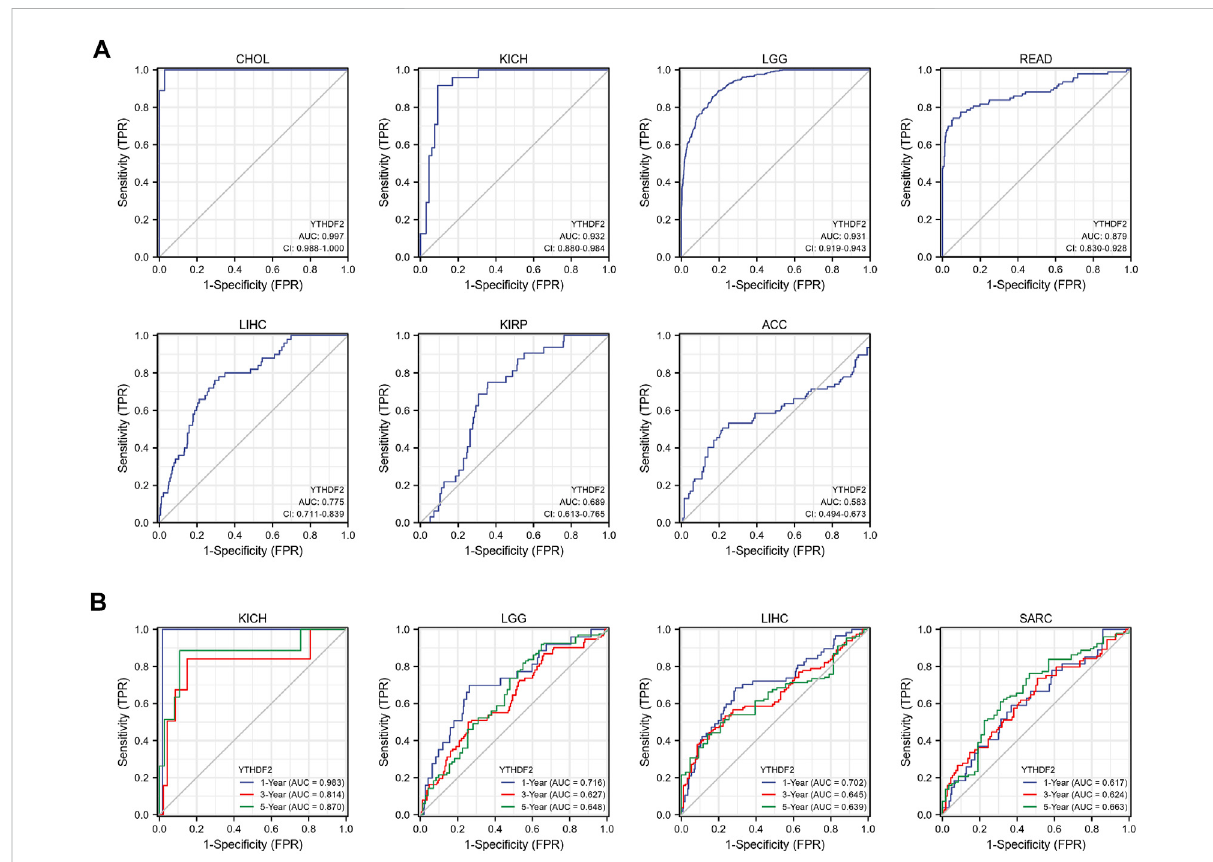
FIGURE 4 The predictive potential of YTHDF2 on prognosis. (A) ROC analysis demonstrates the predictive potential of YTHDF2 on prognosis in CHOL, KICH, LGG, READ, LIHC, KIRP, and ACC. (B) Time-dependent ROC analysis demonstrates the predictive potential of YTHDF2 on 1-year, 3-year, and 5-year survival rate of patients with KICH, LGG, LIH, and